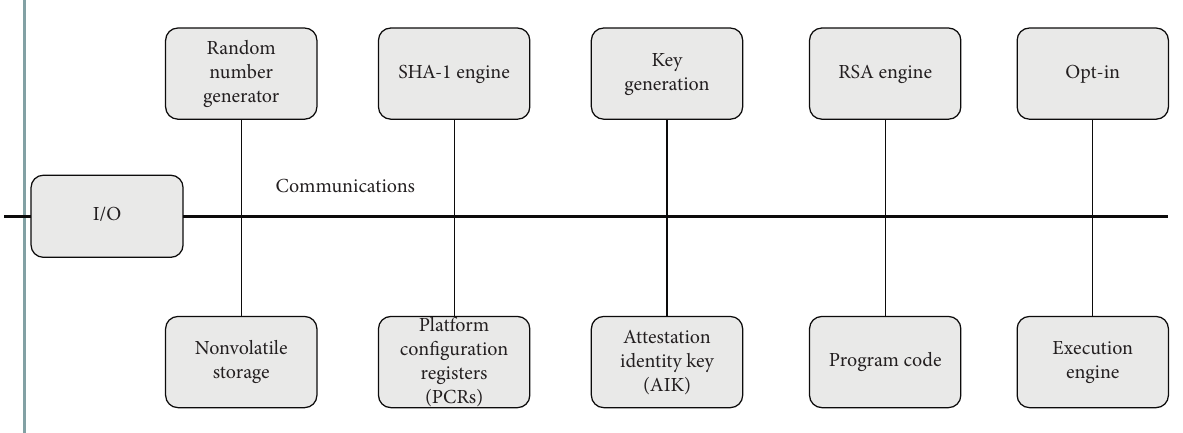
Figure 1: Trusted platform module (TPM) architecture